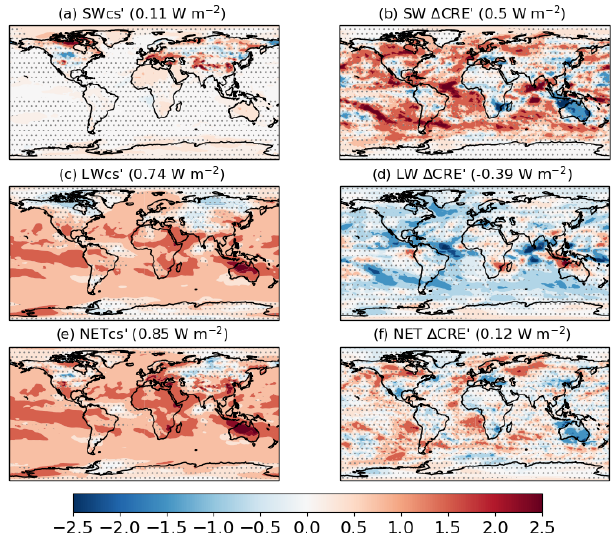
Figure 6. Global distributions of the PD CH 4 ERF components relative to the PI period, i.e. piClim-CH4 minus piClim-control ; (a) SW (cid:48) cs , (b) SW CRE (cid:48) , (c) LW (cid:48) cs , (d) LW CRE (cid:48) , (e) NET (cid:48) cs , and (f) NET CRE (cid:48) , based on Eq. (8). Global mean values are shown in brackets. Regions where the ERF components are outside the 95% confidence level are stippled. Units in Wm − 2